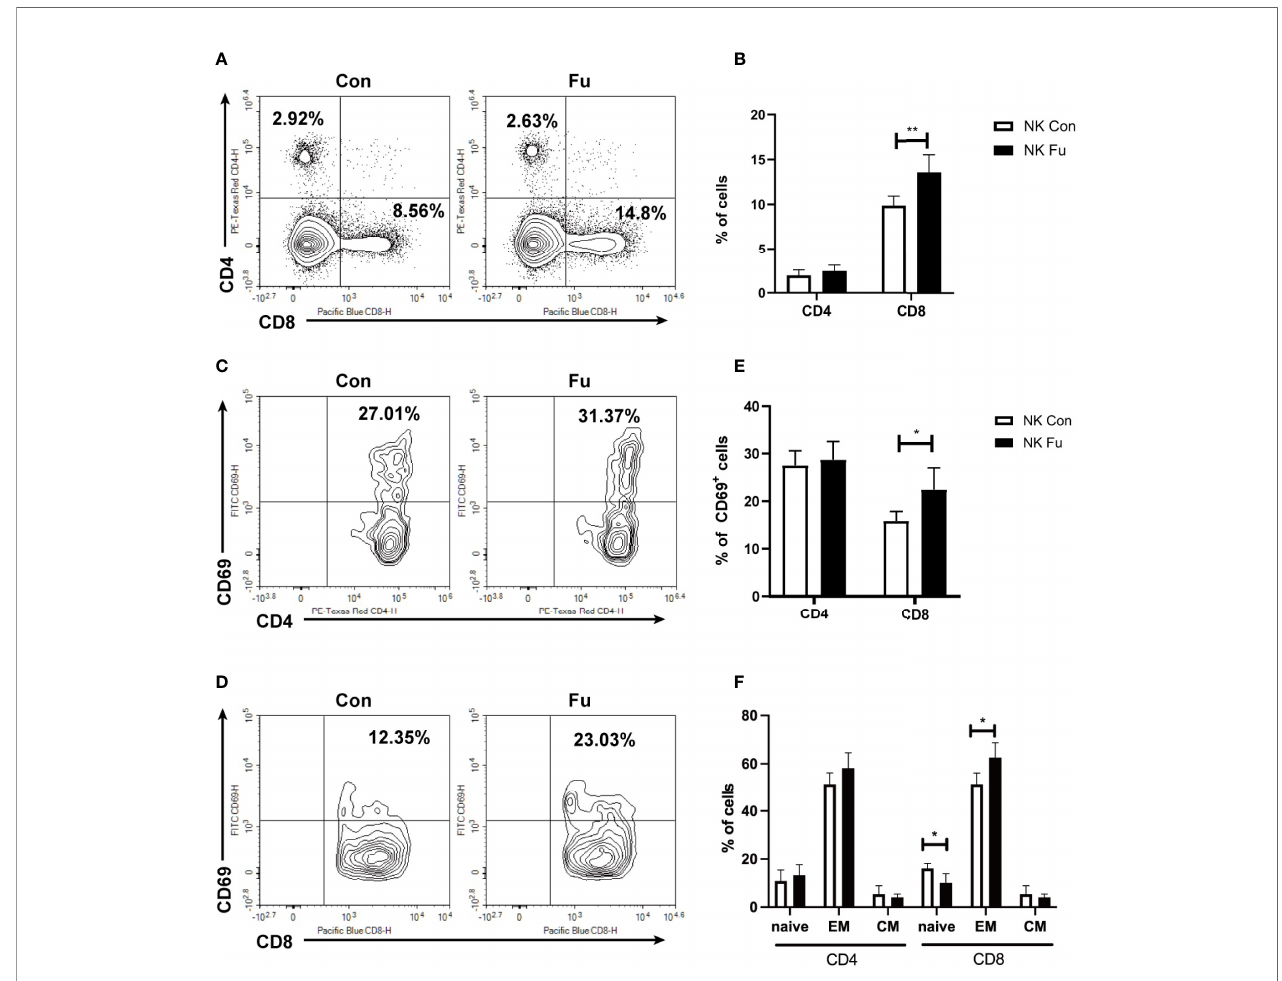
FIGURE 6 | Fucosylation of NK cells triggered T cell anti-tumor T cell responses. BALB/c recipients were lethally irradiated and transplanted of 5x10^6 BM cells together with 5×10^6 A20- luc + /yfp cells. Recipients were transferred with 1x10^6 control NK cells or fucosylaed NK cells, respectively. (A, B) Representative fl ow cytometry plots and summary data of the proportions of CD4 + and CD8 + T cells in recipients 7 days post allo-HCST were shown (n = 5-7 per group). (C – E) Representative fi gures and summary data of the proportions of CD69 + CD4 + T cells and CD69 + CD8 + T cells are depicted (n = 5-7 per group). (F) Populations of naïve, effector memory and central memory CD4 + and CD8 + T cells were detected by fl ow cytometry in recipients received control and fucosylated NK cells 7 days post allo-HCST (n = 5-7 per group). Data are representative of three independent experiments and shown as mean ± SD. * p < 0.05; ** p <